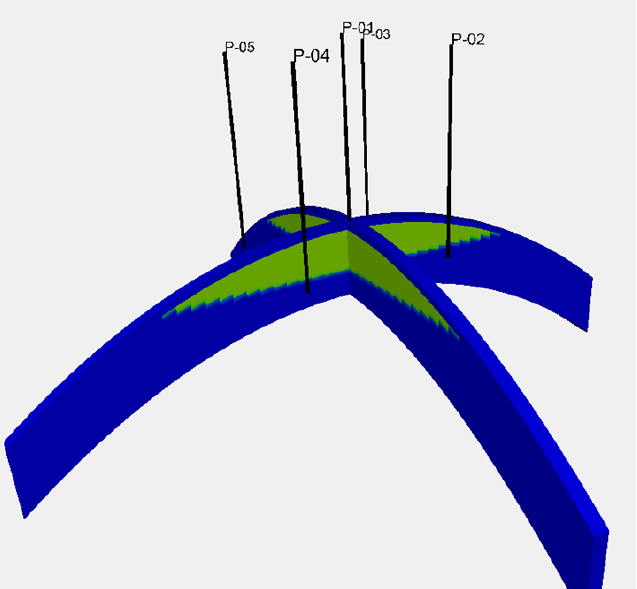
Figure 1. Reservoir model used in the study. A four-way closure reservoir model with the spherical shape of a reservoir top surface. The depth of the reservoir top was 2000 m at the centre of the model. The gas–water contact was located at 2030 m depth. The green colour depicts the gas accumulation above the gas–water contact. The blue colour shows a bottom aquifer below the gas–water contact and the cap rock layers above the top reservoir. Five wells, composing a five-spot pattern with a 2 km side length, were placed in the